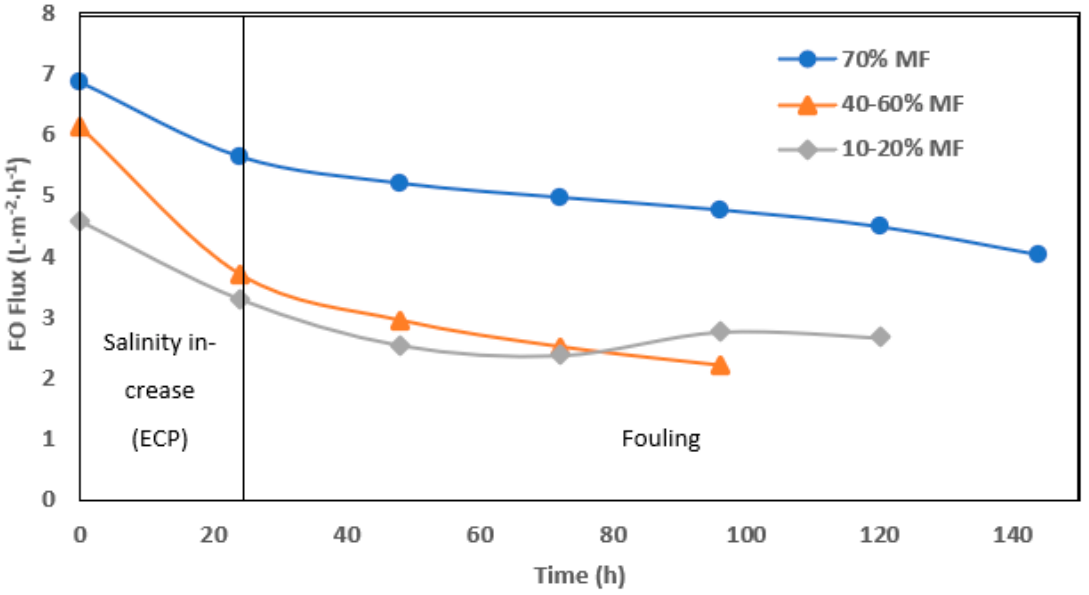
Figure 6. Daily average of FO permeation fl ux with 70%, 40–60%, and 10–20% of MF.